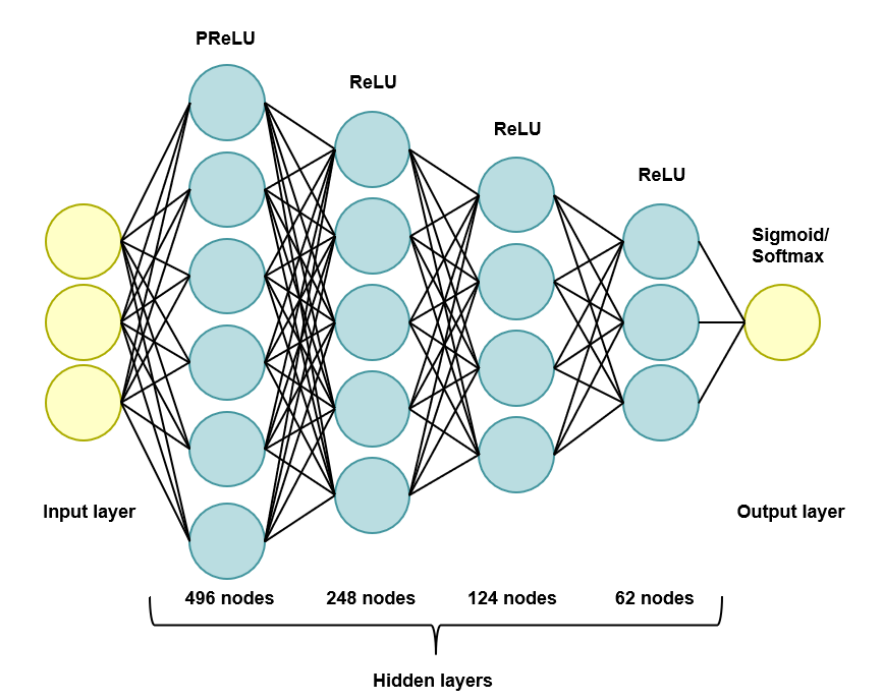
Figure 3. A graphical representation of the DNN